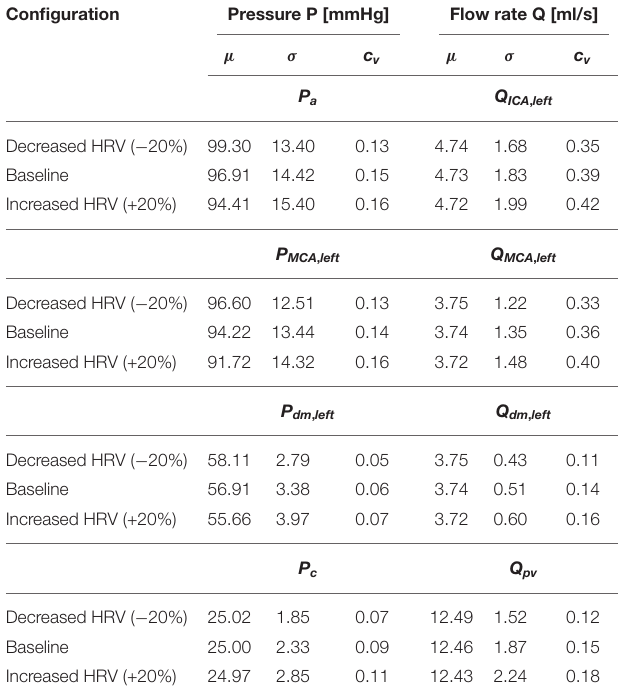
TABLE 1 | Basic statistics (mean: µ , standard deviation: σ , coefficient of variation: c v ) of the continuous time-series along the ICA-MCA pathway: P a , Q ICA , left , P MCA , left , Q MCA , left , P dm , left , Q dm , left , P c , and Q pv